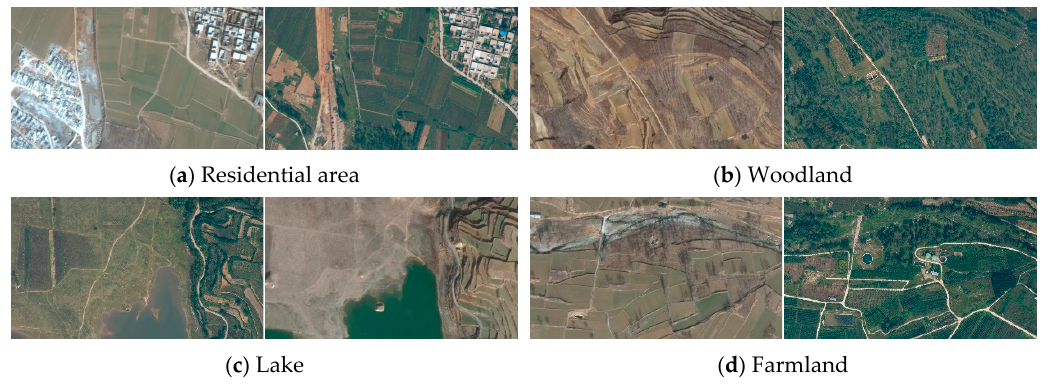
Figure 3. Examples of the images in the dataset.